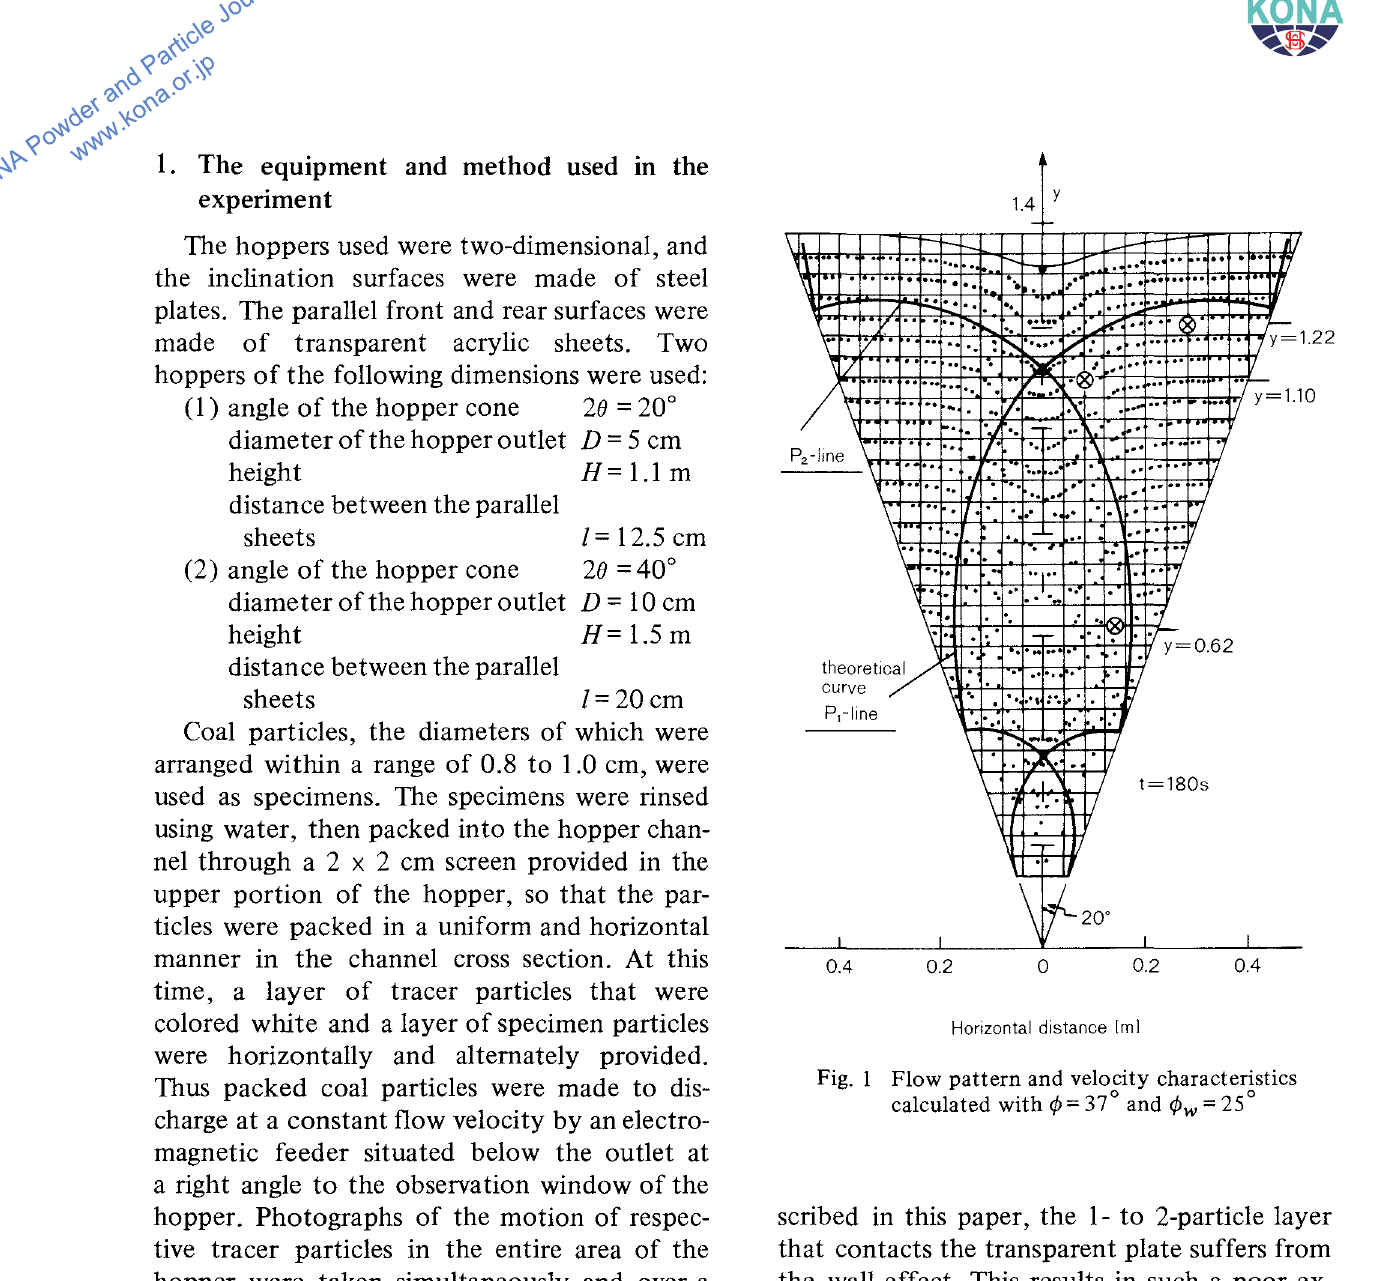
Fig. 1 Flow pattern and velocity characteristics calculated with</>=37° and